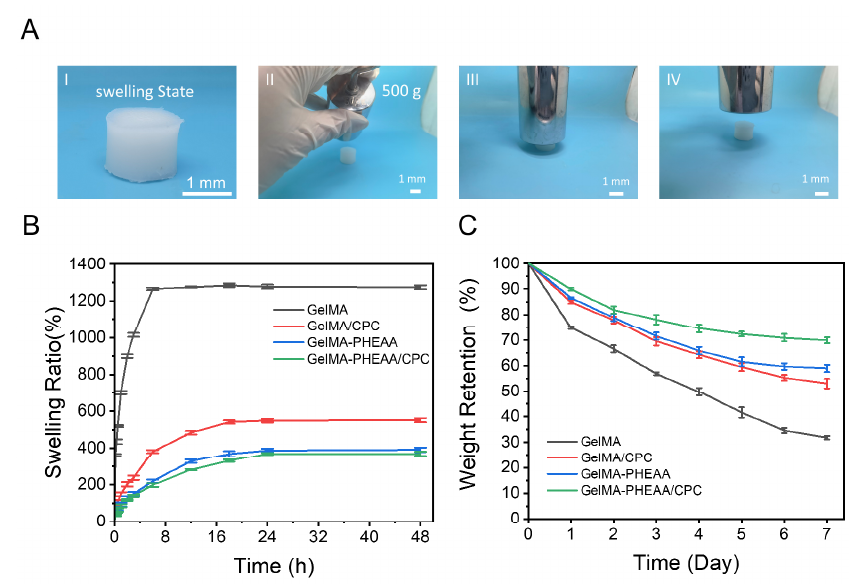
Figure 3. Stability test of the hydrogels. ( A ) The optical images of GelMA-PHEAA/CPC hydrogel in the swelling state. I: shape integrity of the swelling hydrogel. II–IV: the compression process on swollen GelMA-PHEAA/CPC hydrogels using a 500 g hook weight. ( B ) The swelling properties of different hydrogels. ( C ) Biodegradation of hydrogels.